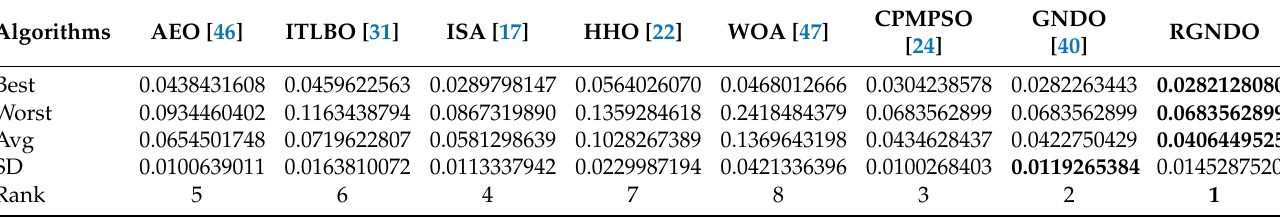
Table 8. Comparison of the fitness on Kyocera KC200GT.